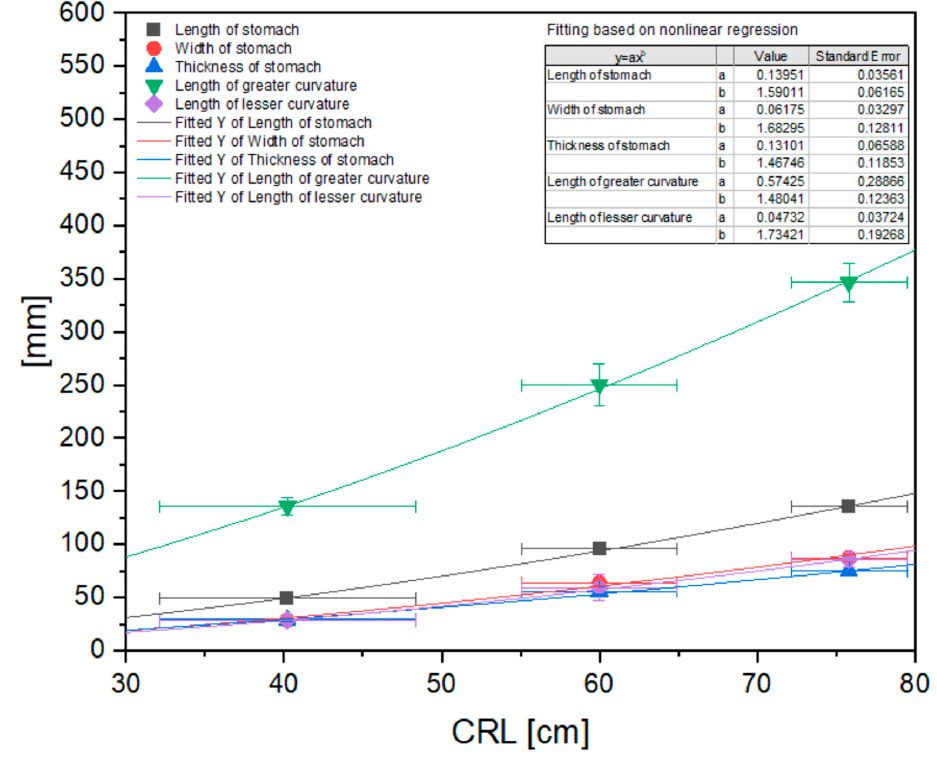
Figure 9. Nonlinear regression of basic stomach morphometric values (length, width, and thickness, and length of the greater and lesser curvature). CRL—crown–rump length.